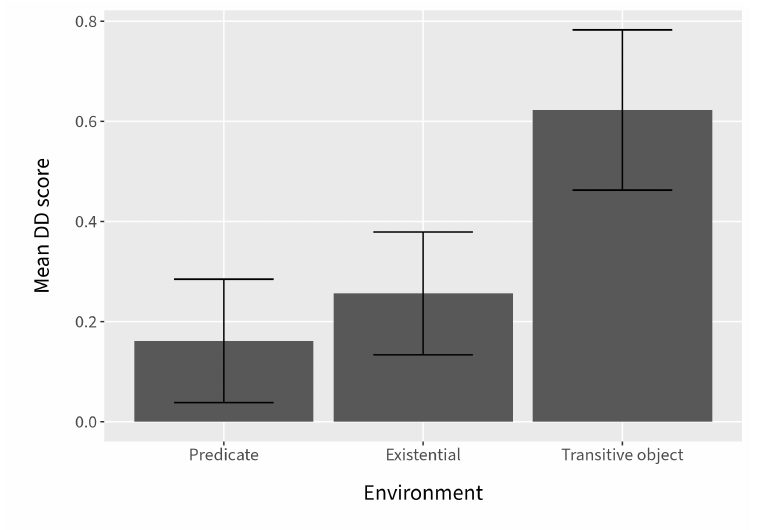
Figure 2. DD scores by Environment (calculated from z-scored ratings). Error bars represent the standard error over DD scores calculated per item. DD scores, left to right: 0.16, 0.26, 0.62. See z-scored ratings by item in Appendix